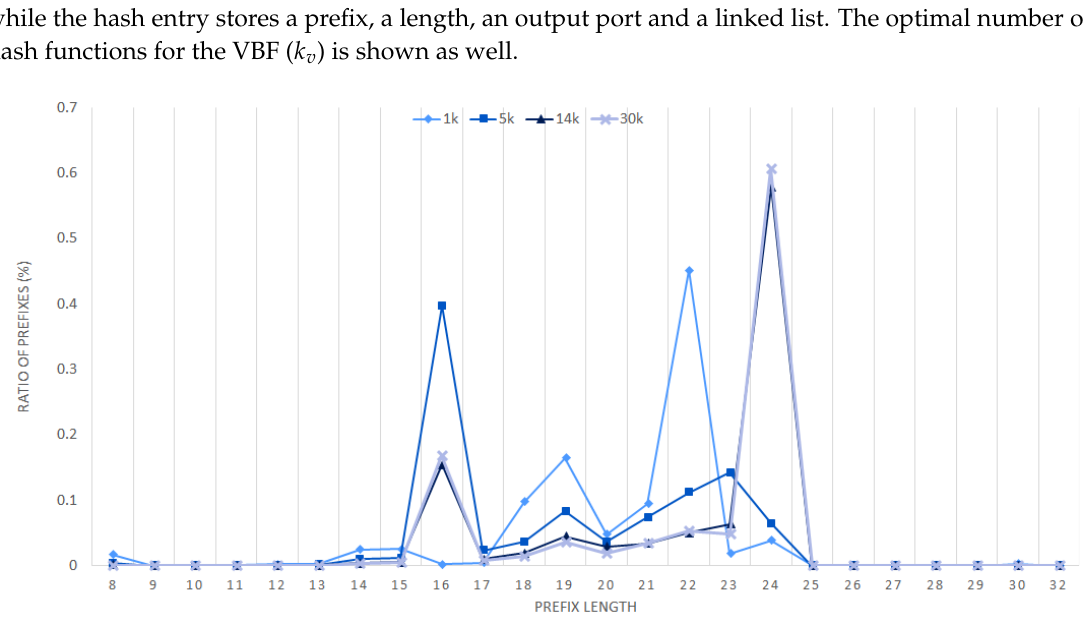
Figure 6. Distribution of the number of prefixes according to prefix